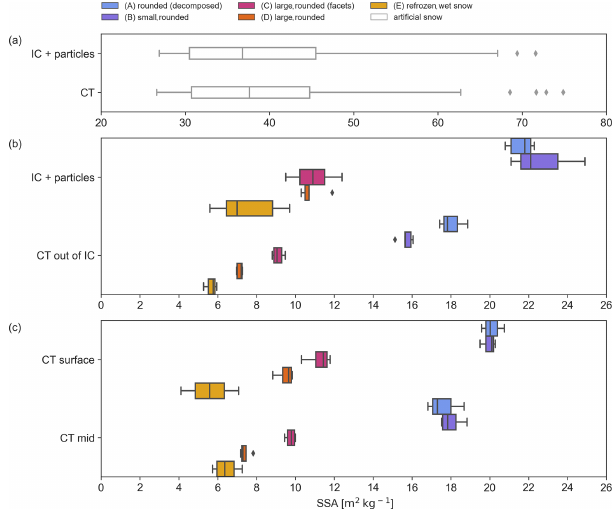
Figure 6. All SSA measurements are classified into sampling steps. The box plots represent the median and interquartile range. “IC + particles” is the default method (Gallet et al., 2009; A2 Pho- tonic Sensors, 2014), “CT” represents the micro-CT measurements out of an IC + particles sample, “CT out of IC” denotes the micro- CT measurements out of an “IC − particles” sample, and “CT sur- face” and “CT mid” refer to the manufactured micro-CT sampling kit. Panel (a) presents the results for the artificial snow data set with SSA values between 30 and 80m 2 kg − 1 . Panel (b) shows the five snow types (A, B, C, D and E); the SSA is between 5 and 25m 2 kg − 1 . Panel (c) shows the results for the micro-CT sampling kit with SSA values between 5 and 22m 2 kg − 1 . All results can be found in Table A1. For access to the data set, the reader is referred to the Code and data availability